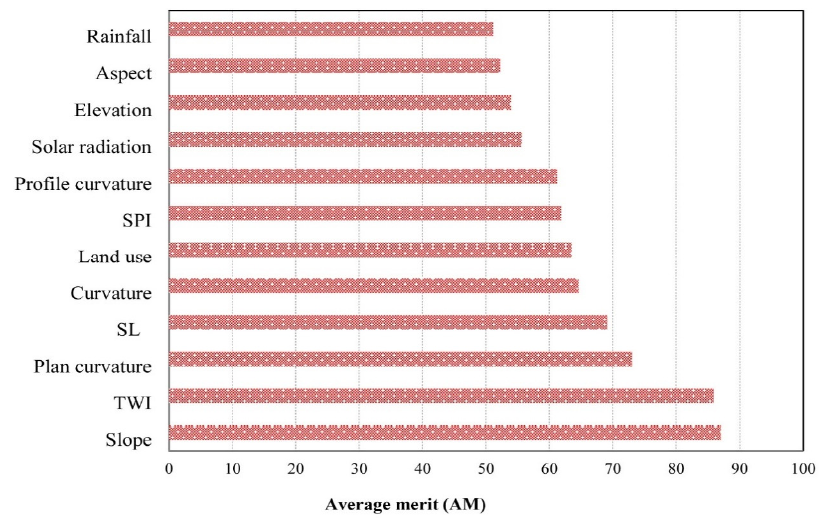
Figure 6. Average merit of shallow landslide factors calculated by the One Rule Attribute Evaluation (ORAE) method.